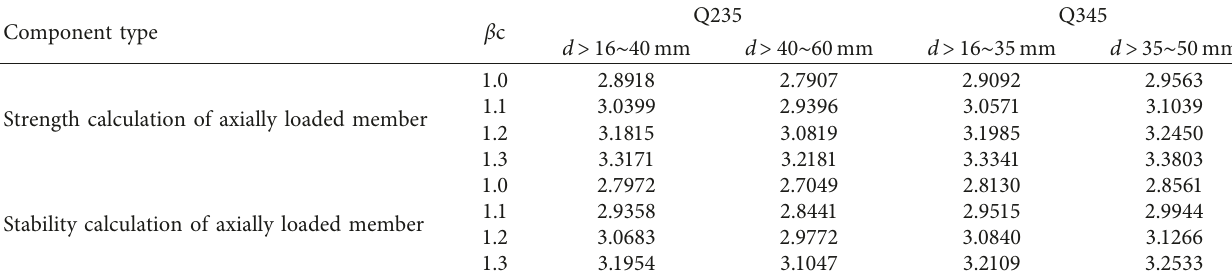
Table 7: The average value of reliability indices of different steel